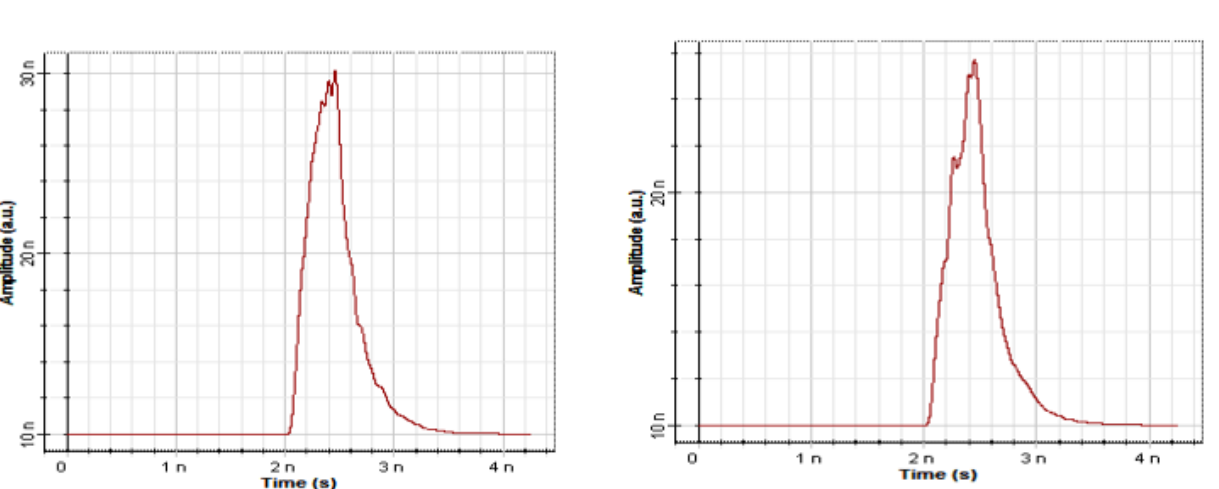
Figure 15. Irradiance angle ( θ s ) effect on an LOS propagation model ( θ s changes from 0 ◦ to 25 ◦